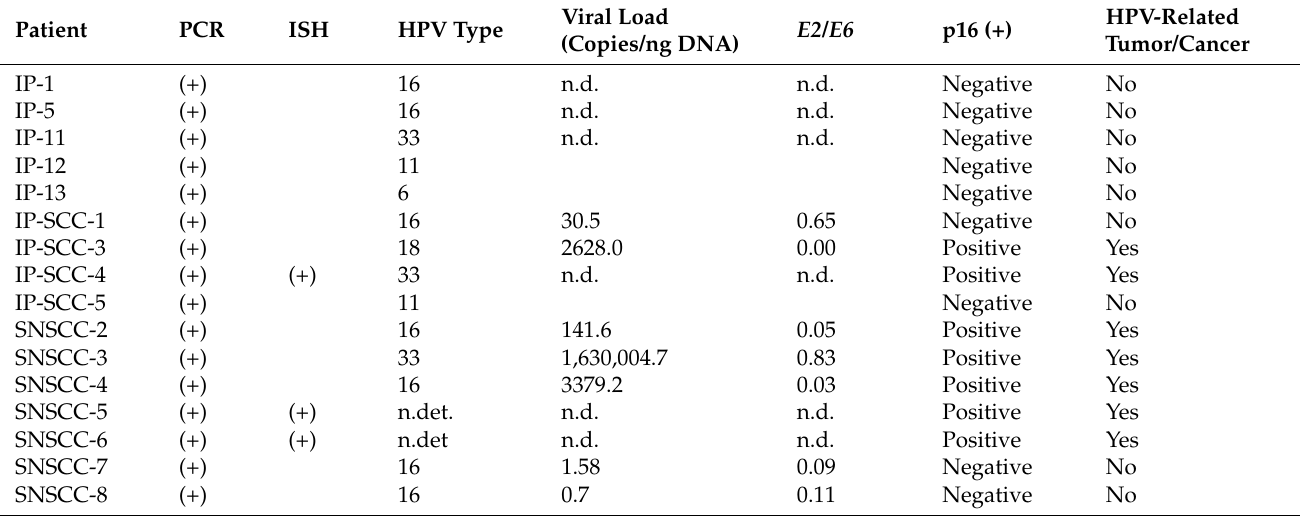
HPV, human papillomavirus; ISH, HPV-DNA in situ hybridization; IP, inverted papilloma; IP-SCC, inverted papilloma, and squamous cell carcinoma; n.d., not detected; n.det., could not be determined; p16 (+), p16 overexpression; SNSCC, sinonasal squamous cell carcinoma.